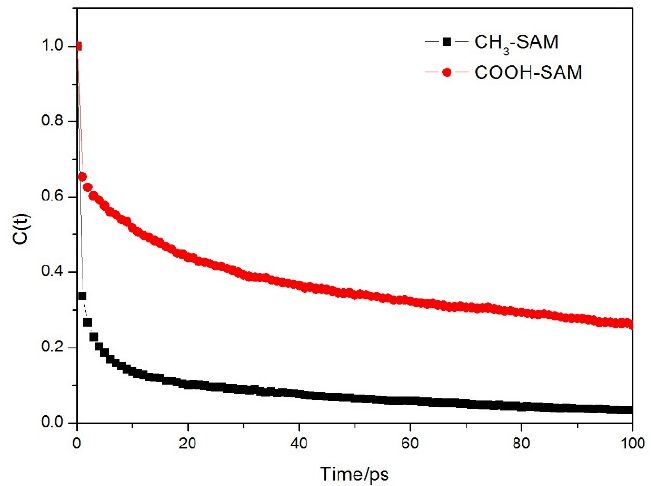
Figure 6. Autocorrelation function of molecules in hydration layer on polymer membrane surface.